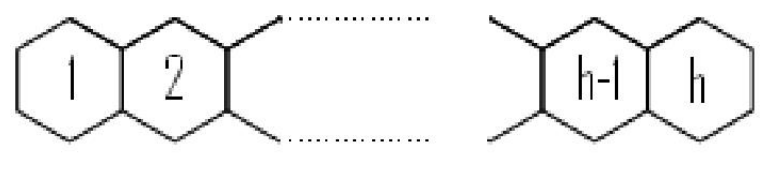
Figure 2: The Molecular Graph of a Linear Chain BC ( h